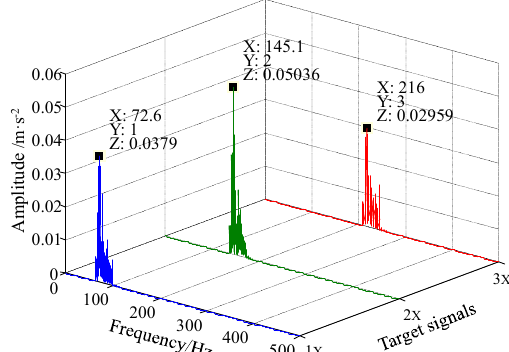
Figure 12. Three-dimensional spectrogram of the bearing outer ring fault signal based on FERSR and frequency recovery.